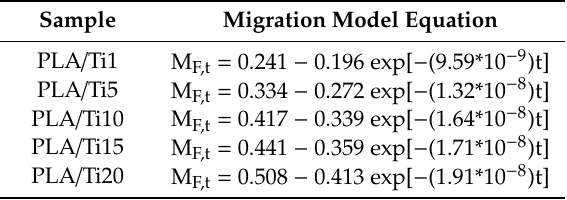
Table 2. Migration model equation of PLA / nano-TiO 2 composite film by high pressure treatment in food simulated